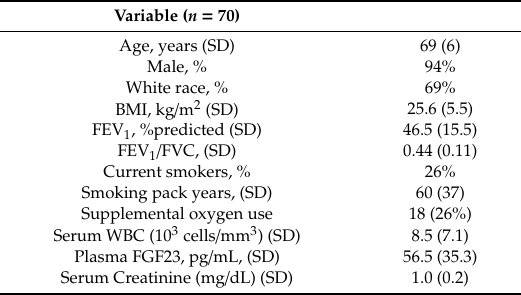
Table 1. Baseline characteristics of study